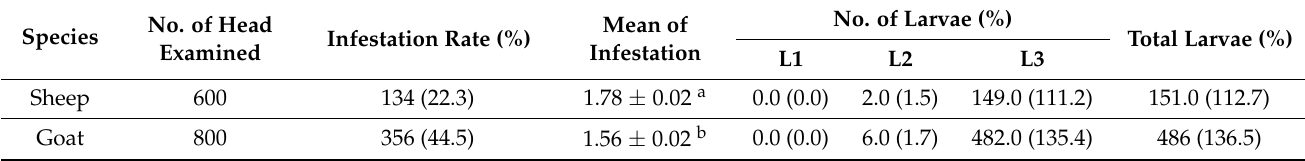
Table 2. Prevalence of Oestrus larvae in sheep and goats over the course of the study.